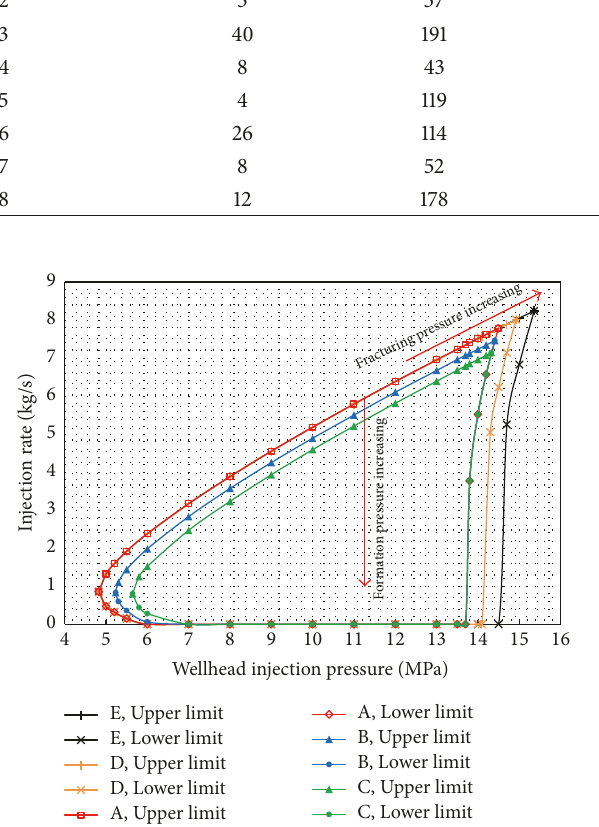
Figure 12: Relationship diagram between wellhead injection pres- sure and injection rate at different formation pressure and fracturing pressure.